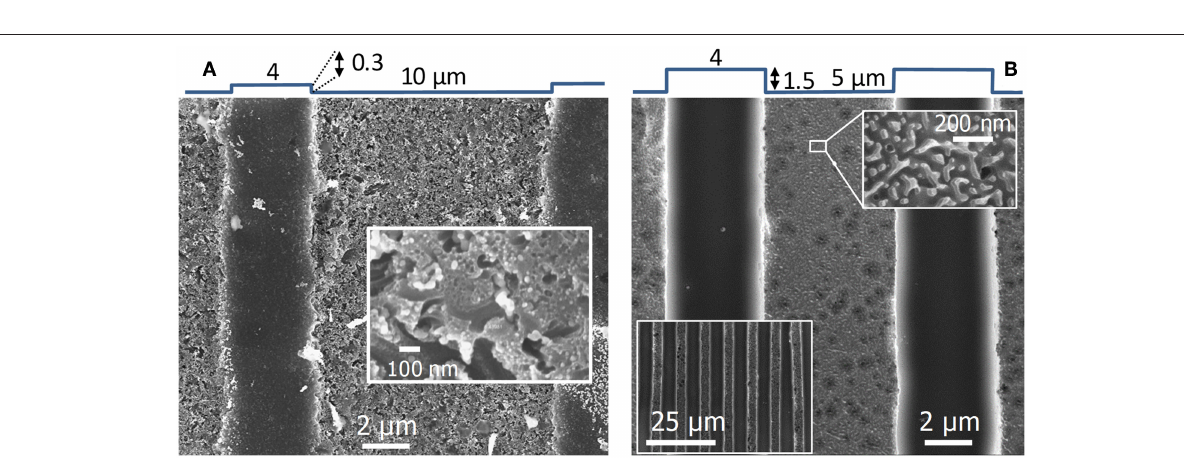
deep are present everywhere. The intersections of facets are relatively rounded, indicating a partial delocalization of etching, probably due to porous silicon formation. SEM observations